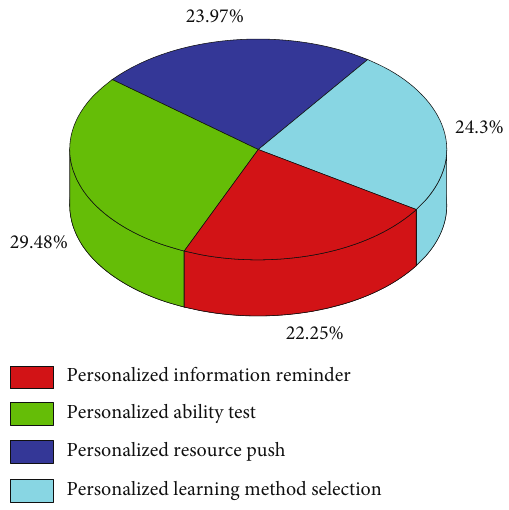
Figure 6: What personalized needs do you want the e-learning platform to